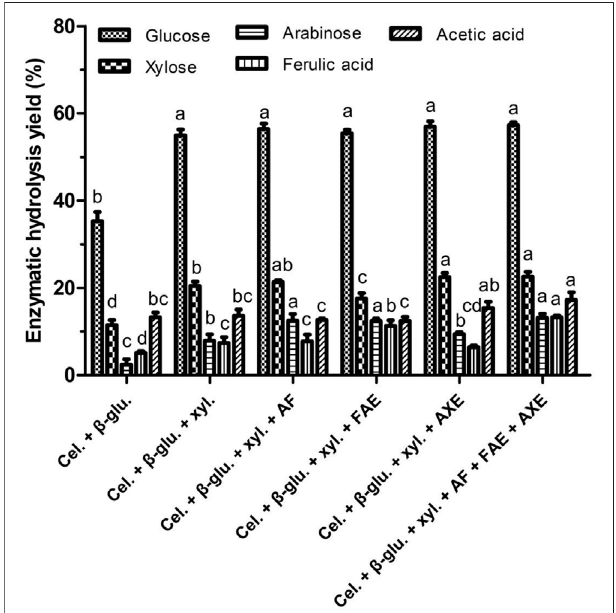
FIGURE 1 | Monosaccharides and ferulic acid release from wheat bran autohydrolysisresiduebycommercialenzymemixtures.Cel.,cellulase; β -glu., β -glucosidase; Xyl., xylanase; AF, arabinofuranosidase; FAE, ferulic acid esterase; AXE, acetyl xylan esterase. Enzymatic hydrolysis yield of the same product between different treatments were conducted for one way analysis of variance (ANOVA) and multiple comparisons, where different lowercase letters indicate signi fi cant difference at p < 0.05 probability